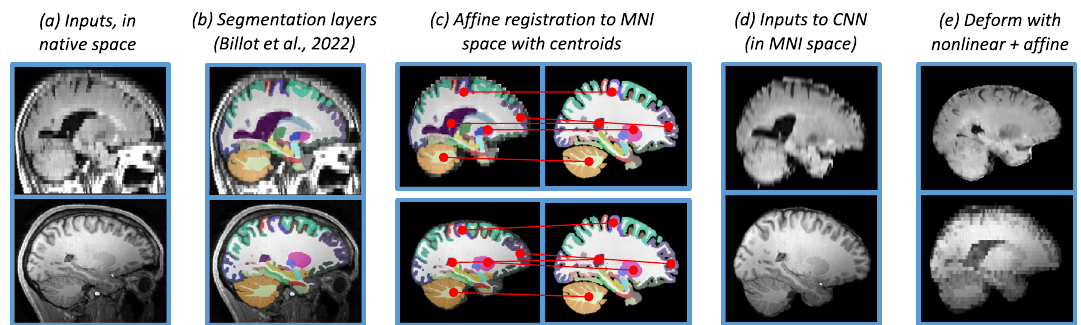
Figure 2. Overview of the inference procedure used by EasyReg , using a 5 mm axial FLAIR scan and a 1 mm isotropic MPRAGE as sample inputs. ( a ) Sagittal slices of the input scans. ( b ) Output of segmentation layers from 27 , which include subcortical structures and cortical parcels. ( c ) The centroids of the different labels are used to compute an affine transform to MNI space using least squares regression; the centroids of the MNI atlas are precomputed. ( d ) The transforms are used to bring the two (skull-stripped) scans into the voxel space of the MNI reference, which is the space where the CNN was trained. ( e ) The CNN is used to compute the forward and backward deformation fields, which are composed with the affine transforms in order to obtain the final fields and finally deform the original